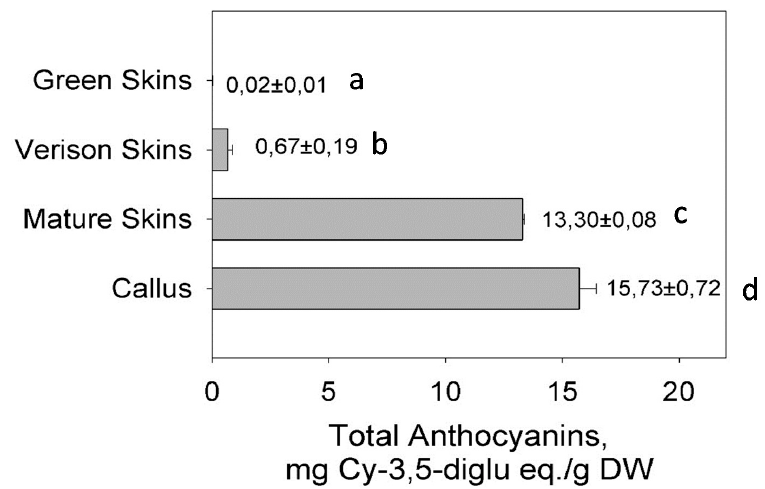
Figure 7. Analysis of anthocyanin accumulation in in vitro cell cultures (Callus), as well as in different development stages of muscadine berry skins (Mature, Veriason, and Green skins). Mean values with different small letters ( a – d ) are significantly different at ( p = 0.01). The accumulation pattern of anthocyanins follows the pattern of expression of VrMybA1, and VrMYBCS-1 .